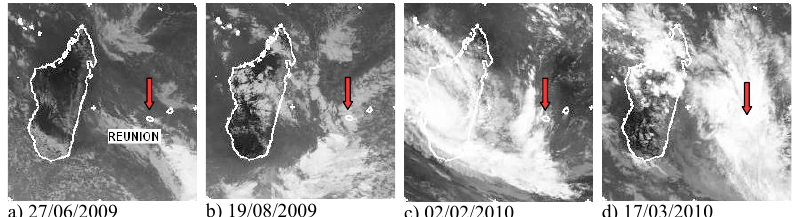
Fig. 6. Thermal infrared (10.5–12.5µm) Meteosat VISSR (visible and infrared spin-scan radiometer) Indian Ocean data coverage (IODC) Figure 6 : Thermal infrared (10.5-12.5 um) Meteosat VISSR Indian Ocean Data Coverage 707 (IODC) images at 1200 UTC and a) 27 Jun. 2009, b) 19 Aug 2009 c) 02 Feb. 2010 and d) 17 708 images at 12:00UTC and (a) 27 June 2009, (b) 19 August 2009 (c) 2 February 2010 and (d) 17 March 2010.